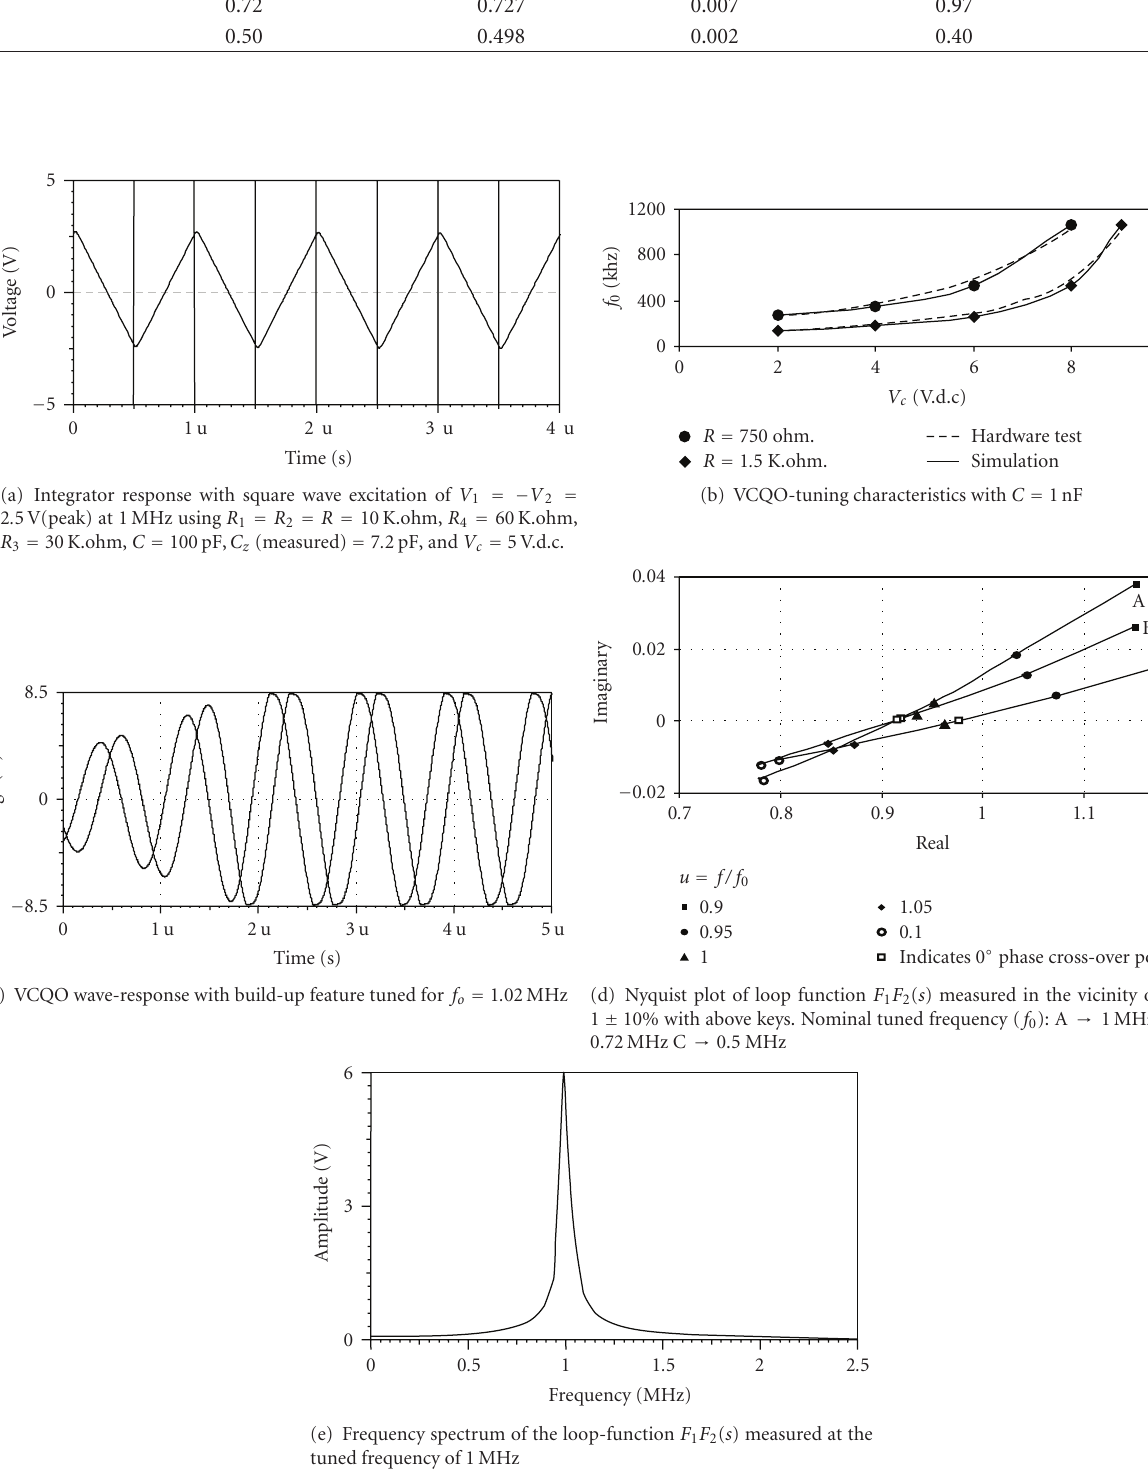
Figure 2: Experimental